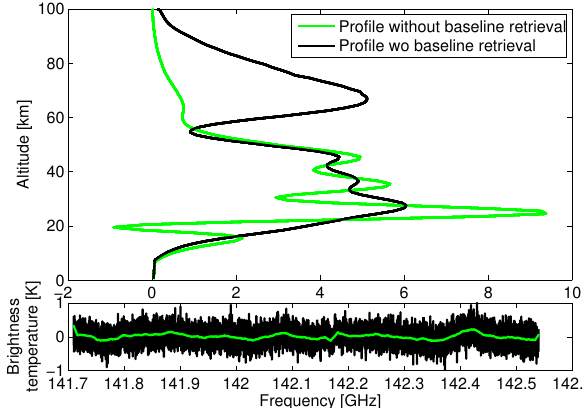
Fig. 6. A retrieval of the spectrum 25 February 2009 (same spec- trum as in Figs. 3 and 4) without the retrieval of the sinusoidal base- line features. A running mean has been applied to the residuum (green